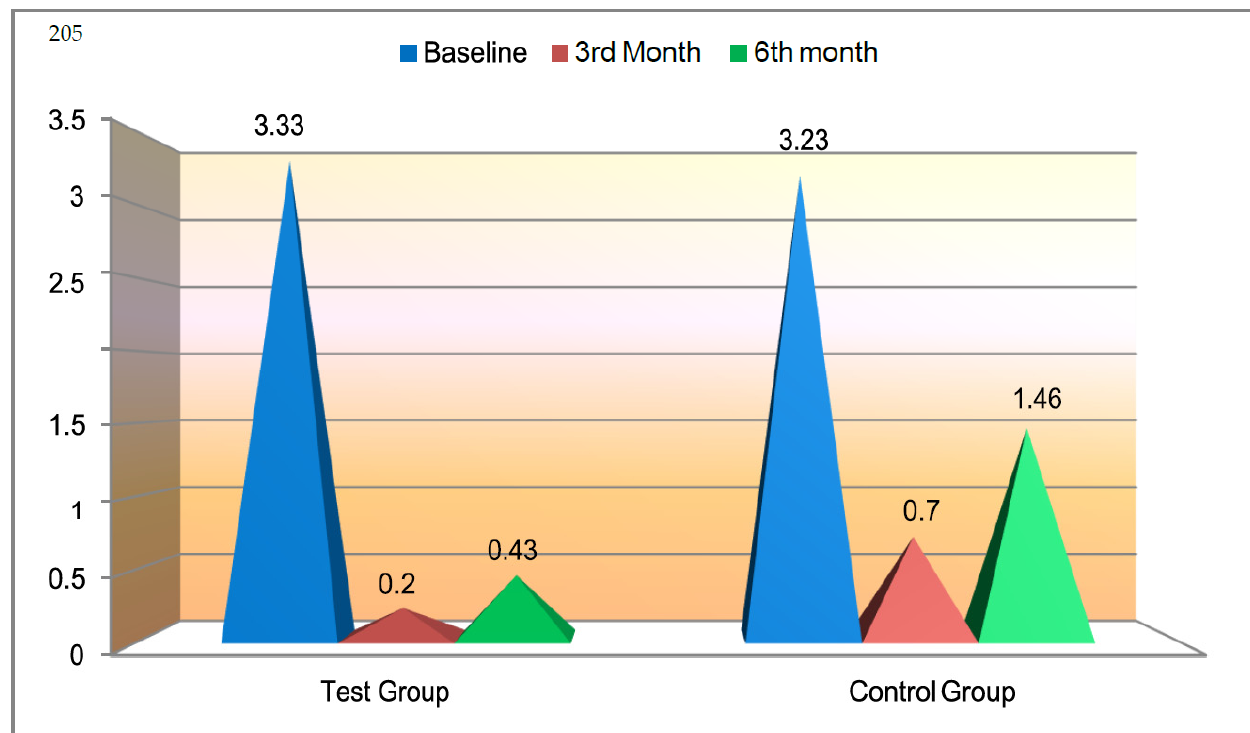
Figure 3. Intra-group comparison of gingival recession depth. Table 2. Inter-group comparison of gingival recession depth.